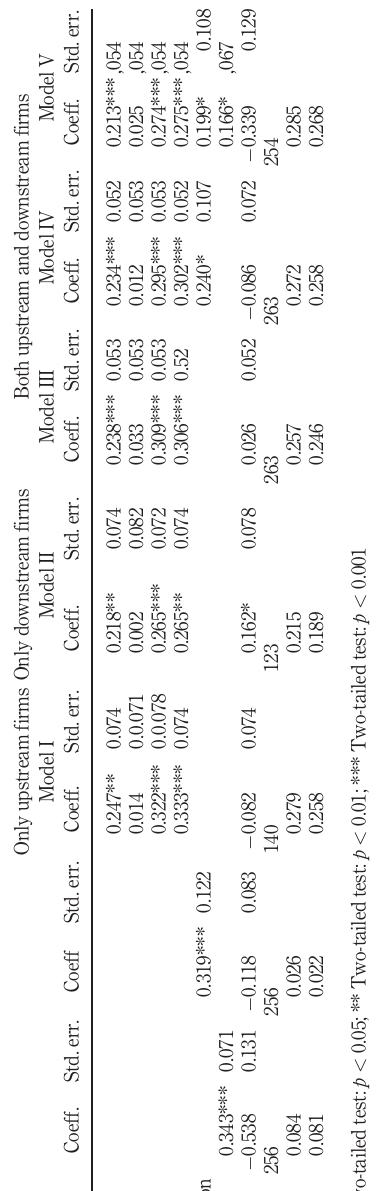
Table 3. Regression analysis of innovation capabilities